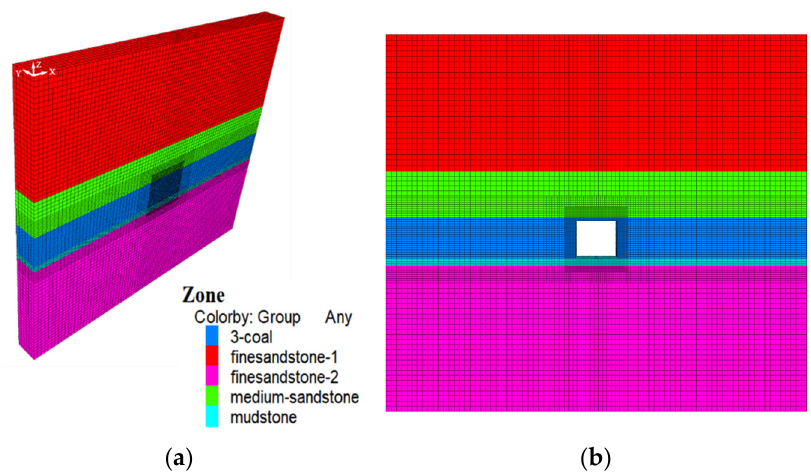
Figure 7. Return air roadway engineering geological model. ( a ) Initial geologic model; ( b ) Excavation of the return airway.